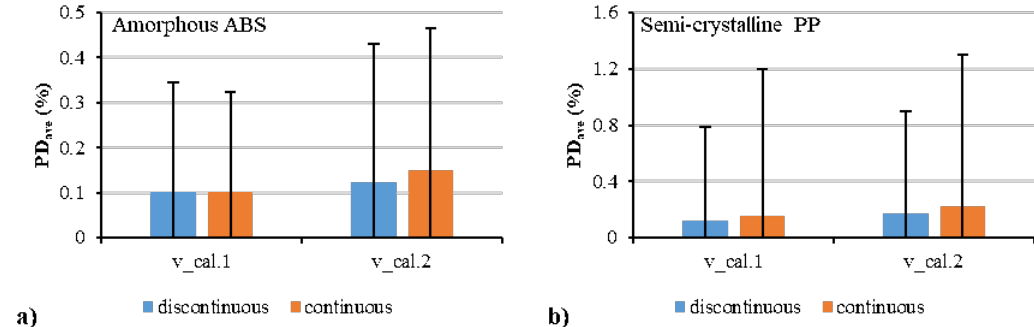
Figure 8. Average absolute percentage deviations between the calculated data from the experimental data: amorphous polymer ( a ) and semi-crystalline polymer ( b ).